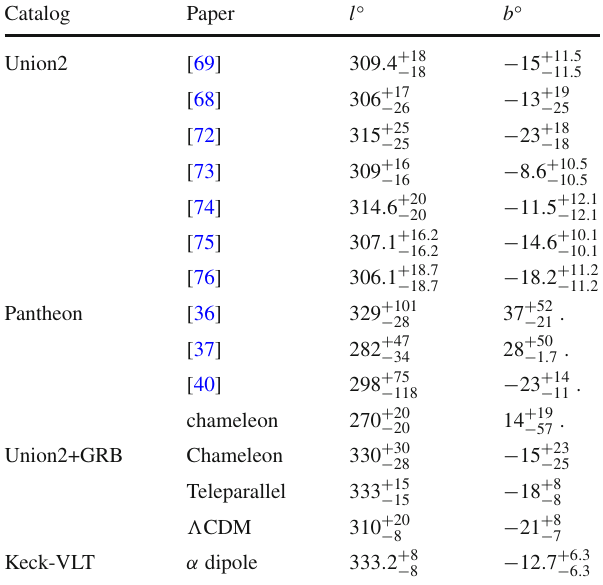
Table 2 Comparison of the maximum anisotropy for different